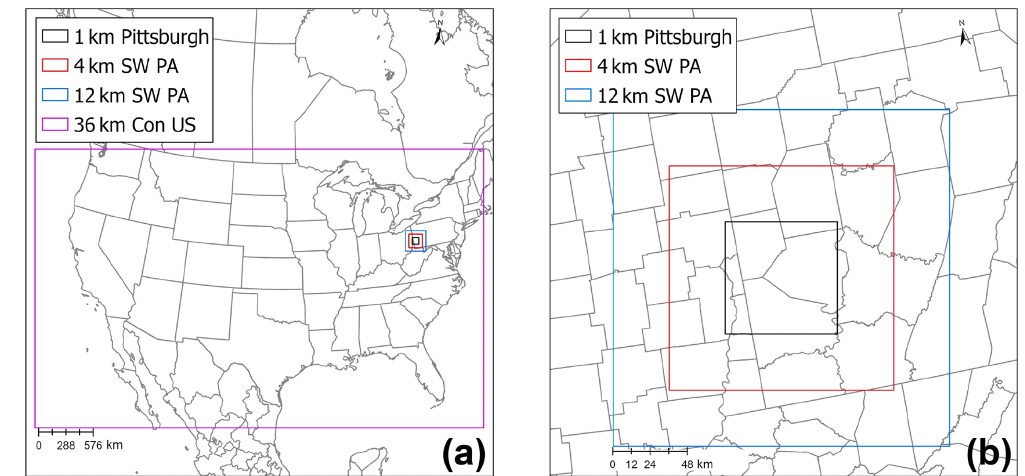
Figure 1. Modeling domain used for the PMCAMx simulations. (a) 36 × 36km continental US grid. (b) 12 × 12 and 4 × 4km southwestern Pennsylvania grids, as well as 1 × 1km Pittsburgh nested